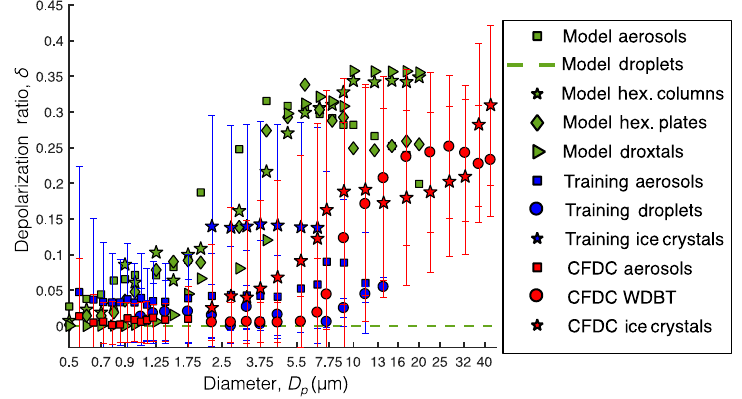
Figure 6. Mean depolarization ratios vs. particle diameter for modeled and observed particles. Observed error bars provide a standard deviation on the depolarization ratios of particles at each reported size. No error bars are reported for model calculations.